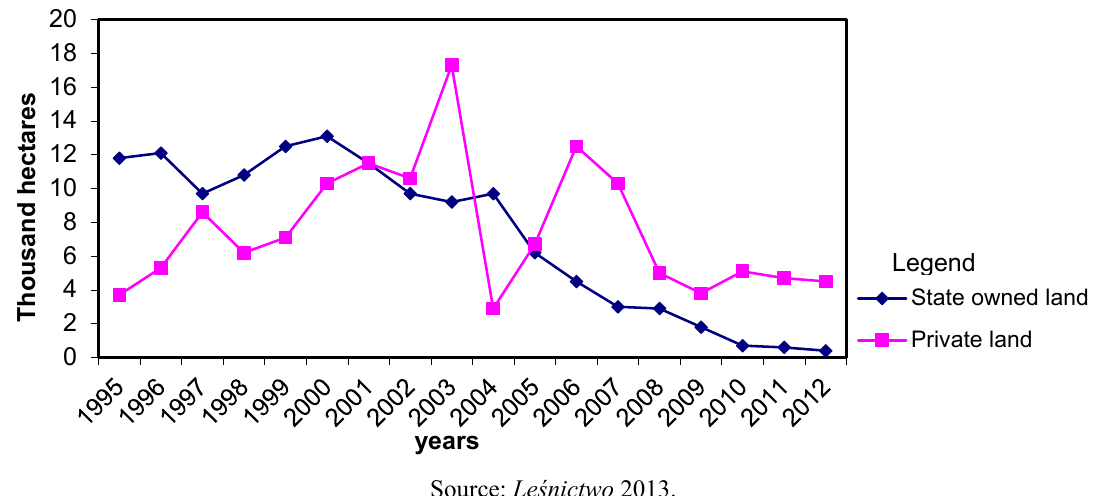
Source: Leśnictwo